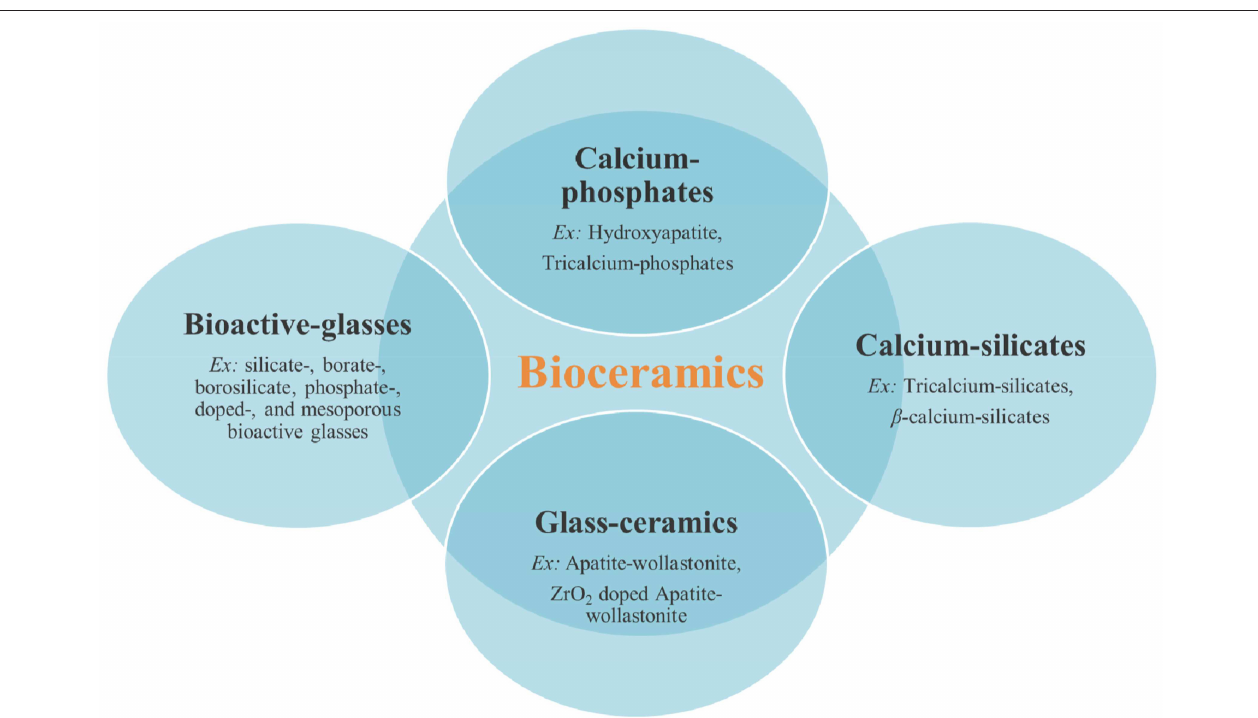
FIGURE 3 | Schematic of the different types of